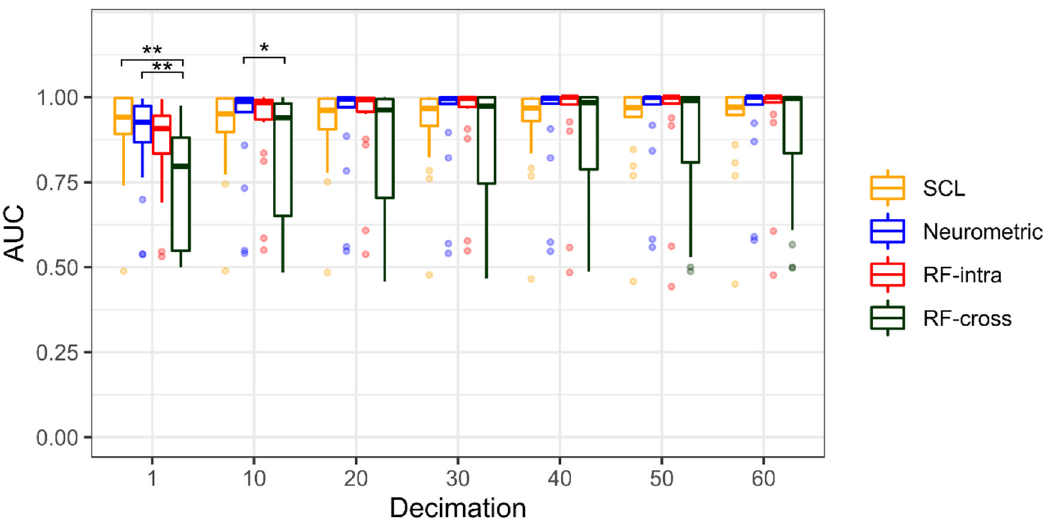
Figure 7. Boxplot representation of Area Under Curve (AUC) for seven different decimations (1 to 60 by 10 s step) of driving experiment. The Random Forest calibrated cross-task (RF-cross) is represented in green, the Random Forest calibrated intra-subject (RF-intra) in red, the Neurometric in blue, and the Skin Conductance Level (SCL) in orange. The points represent the outliers and the asterisk shows that p < 0.05 (the double-asterisk means p < 0.01) resulting from the Dunn’s post-hoc